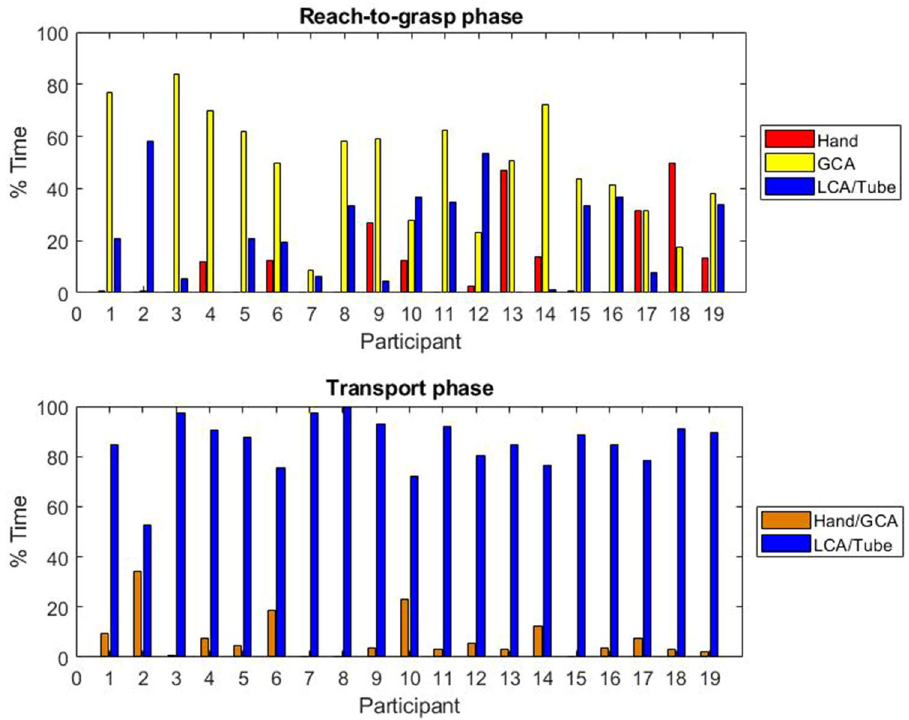
Figure 7. Mean time spent looking at each Area of Interest as a percentage of the reach-to-grasp and transport phases. Missing data and time spent looking at parts of the task other than the hand, cylinder and tube are not displayed. Gaze data was only recorded for 19 participants. GCA = Grasp critical area of cylinder, LCA = Location critical area of